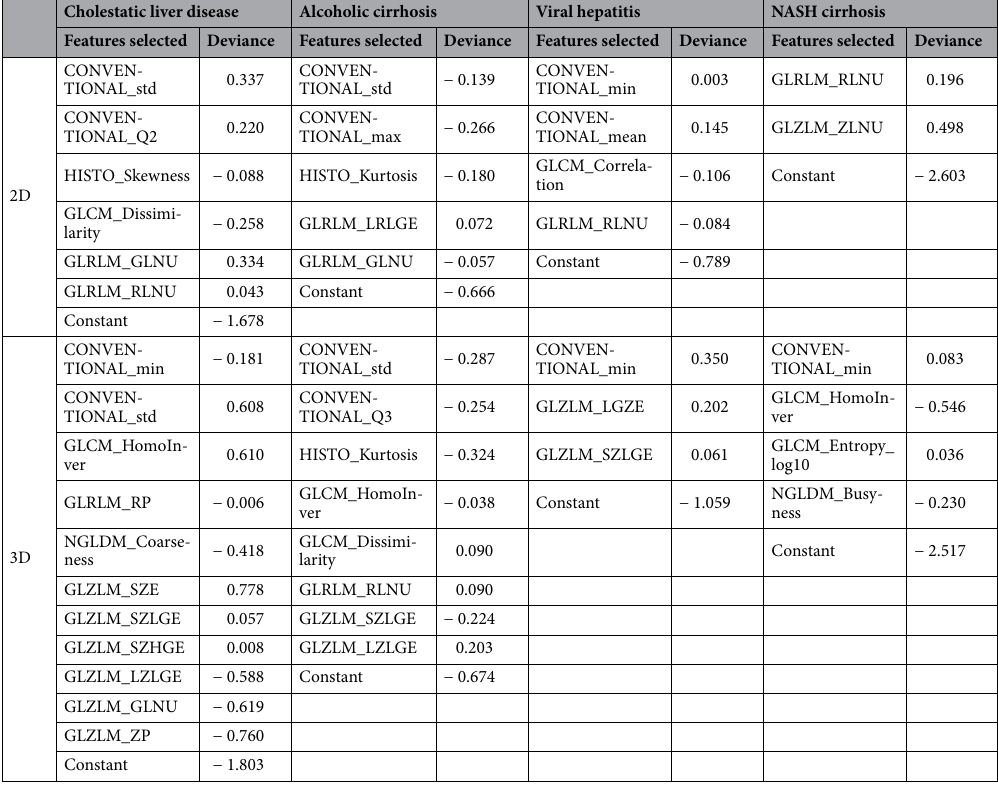
Table 6. Features selected using the least absolute shrinkage and selection operator (LASSO) logistic regression analysis. NASH, nonalcoholic